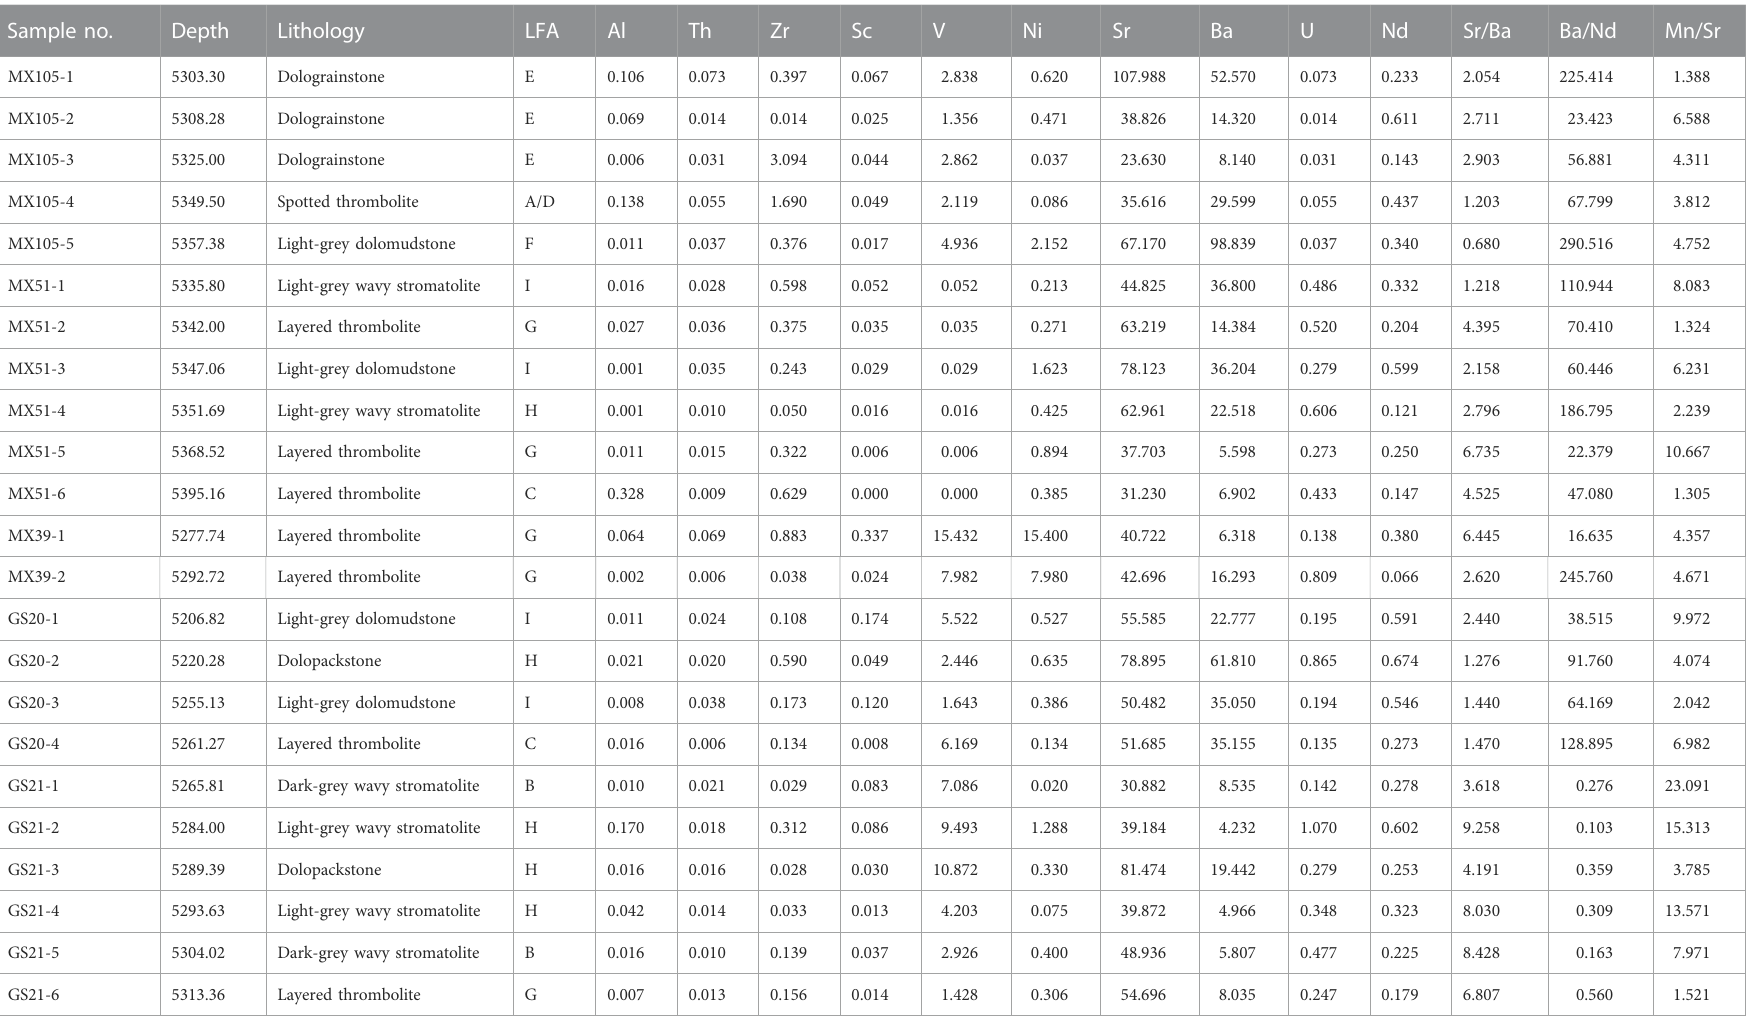
TABLE 1 Al content (%), trace element concentrations (ppm) and ratios of the studied samples (LFA, lithofacies association). Sample